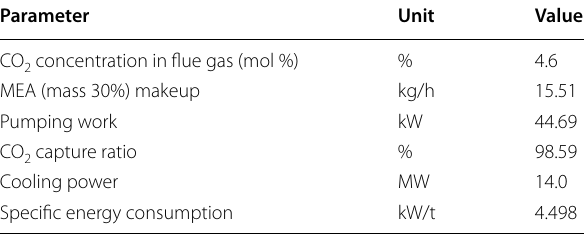
Table 5 Modeling results and key parameters of MEA